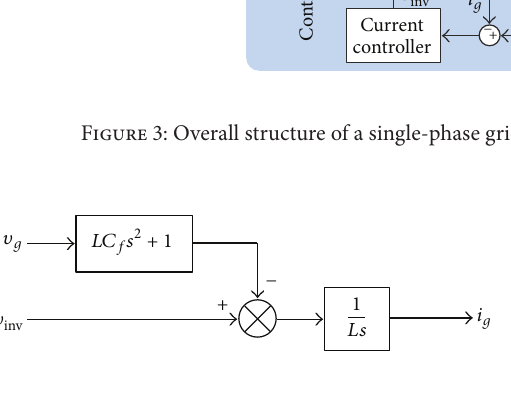
Figure 4: Equivalent model of the output 𝐿𝐶 filter in the Laplace